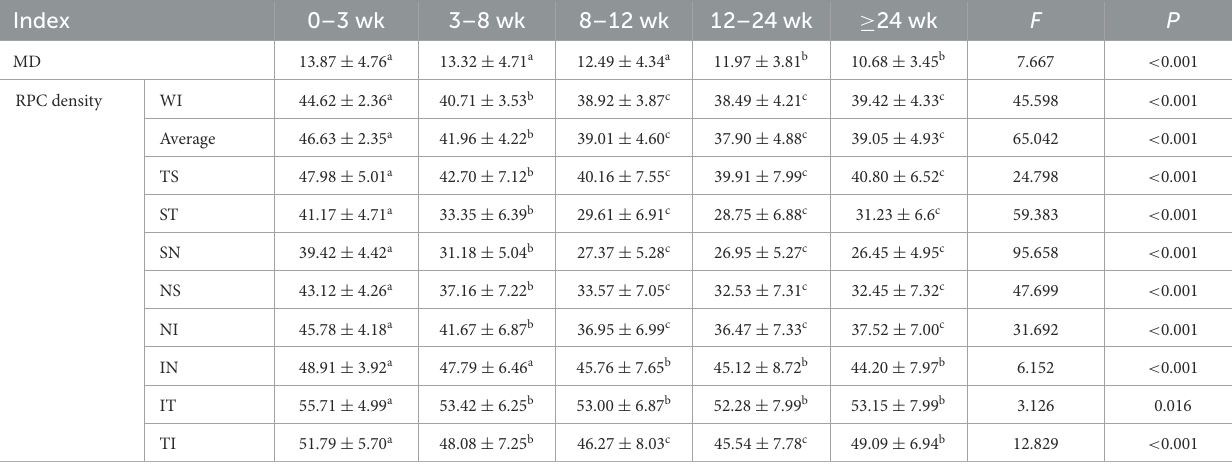
TABLE 1 Longitudinal changes of the visual field and RPC density in patients undergoing serial OCTA at different stages of